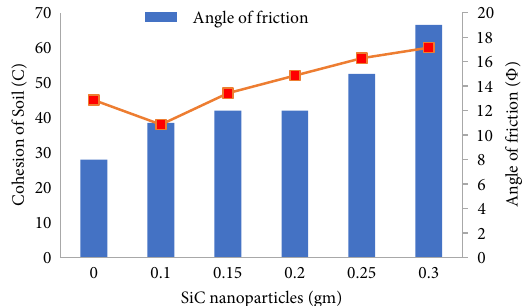
Figure 3. Effect of SiC nanoparticles on Cohesion of the soil and Angle of friction of the soil